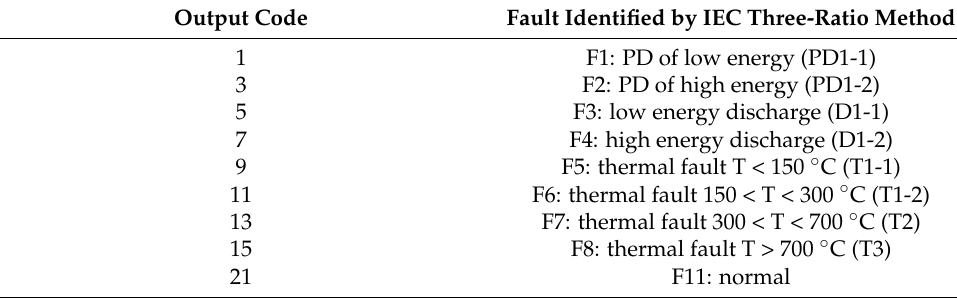
Table 9. Fuzzy output code, function, and fault type using the IEC ratio